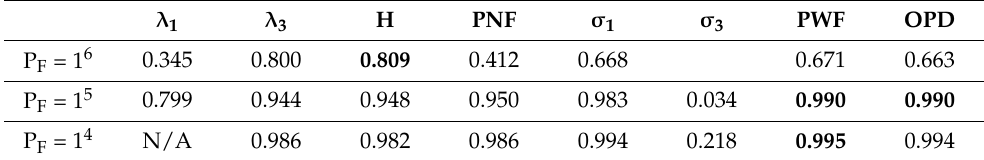
Table 2. Probabilities of detection for quad-polarimetric open ocean. Bold numbers indicate highest P D values.